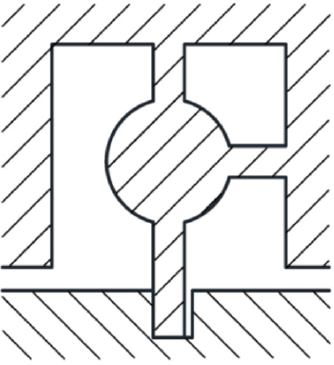
Figure 5. Structure of the shear pin.